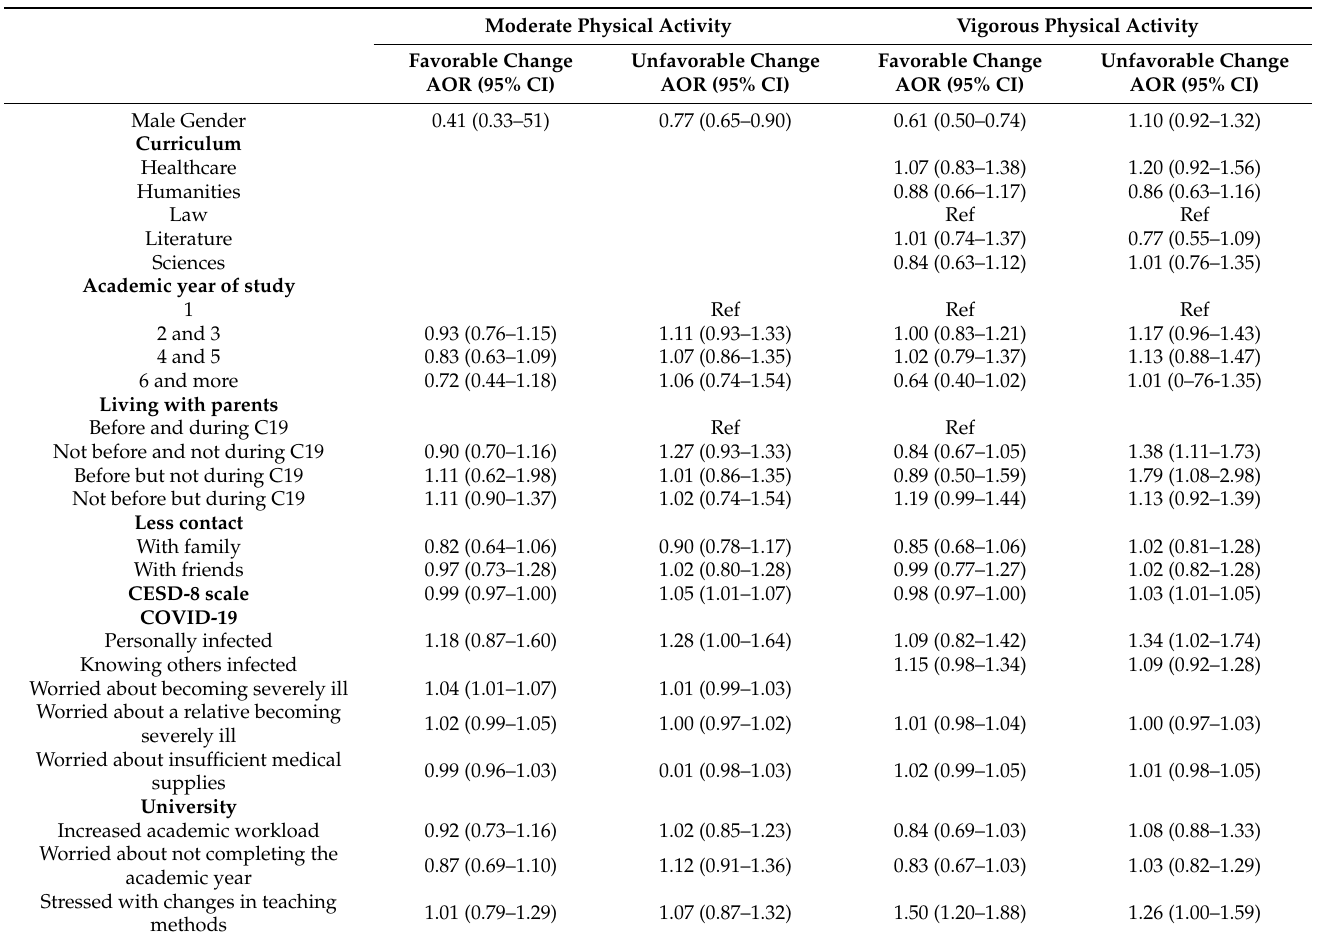
Table 3. Factors associated with favorable and unfavorable changes in moderate and vigorous physical activity among university students during the COVID-19 lockdown ( n =